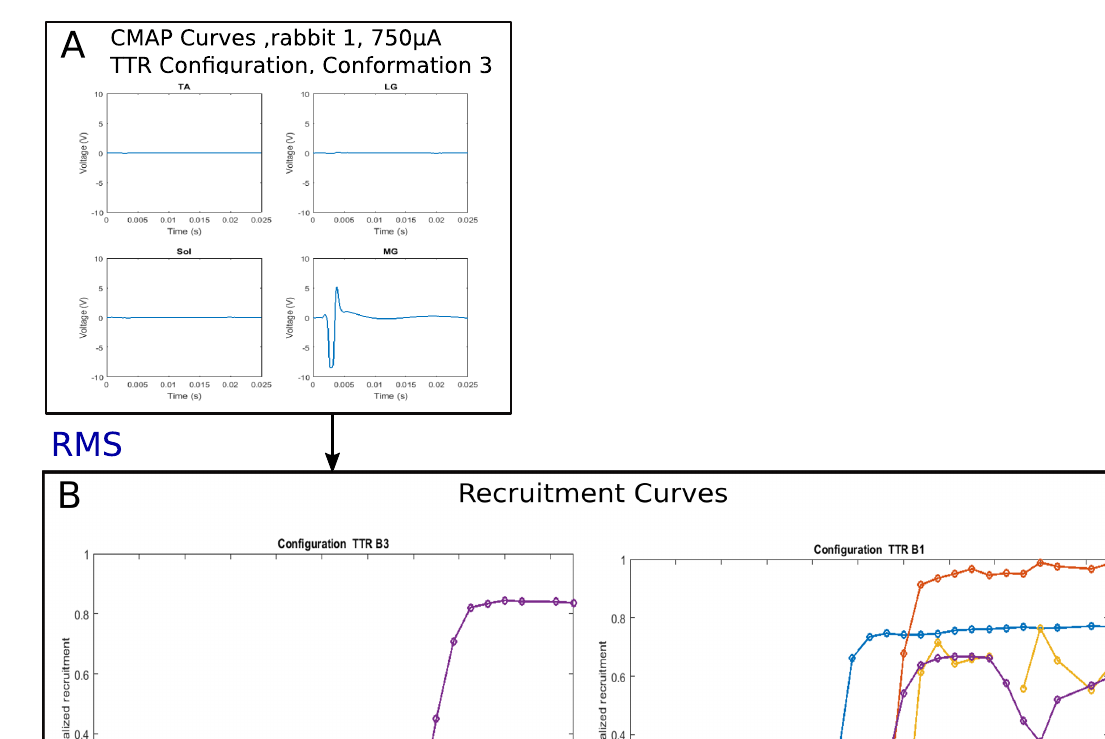
Fig 4. Different steps of the signal processing illustrated through data from Rabbit 1 with TTR configuration. A example of CMAPs collected for each muscle, configuration TTR(B3). B Recruitment curves obtained after the computation of RMS: TTR(B3) (left) and TTR (B1) (right). C Selectivity curves obtained for TTR(B3) (left) and TTR(B1) (right). Missing point corresponds to data that could not be recorded.